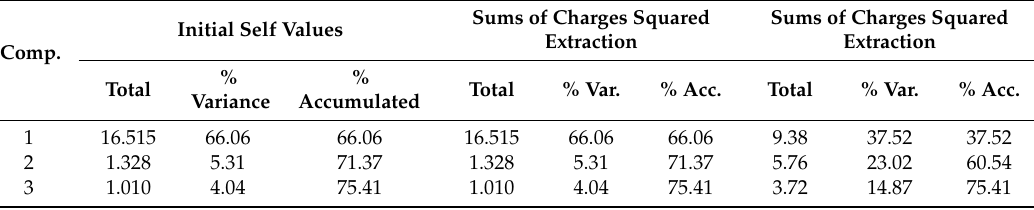
Table 10. Total variance explained.